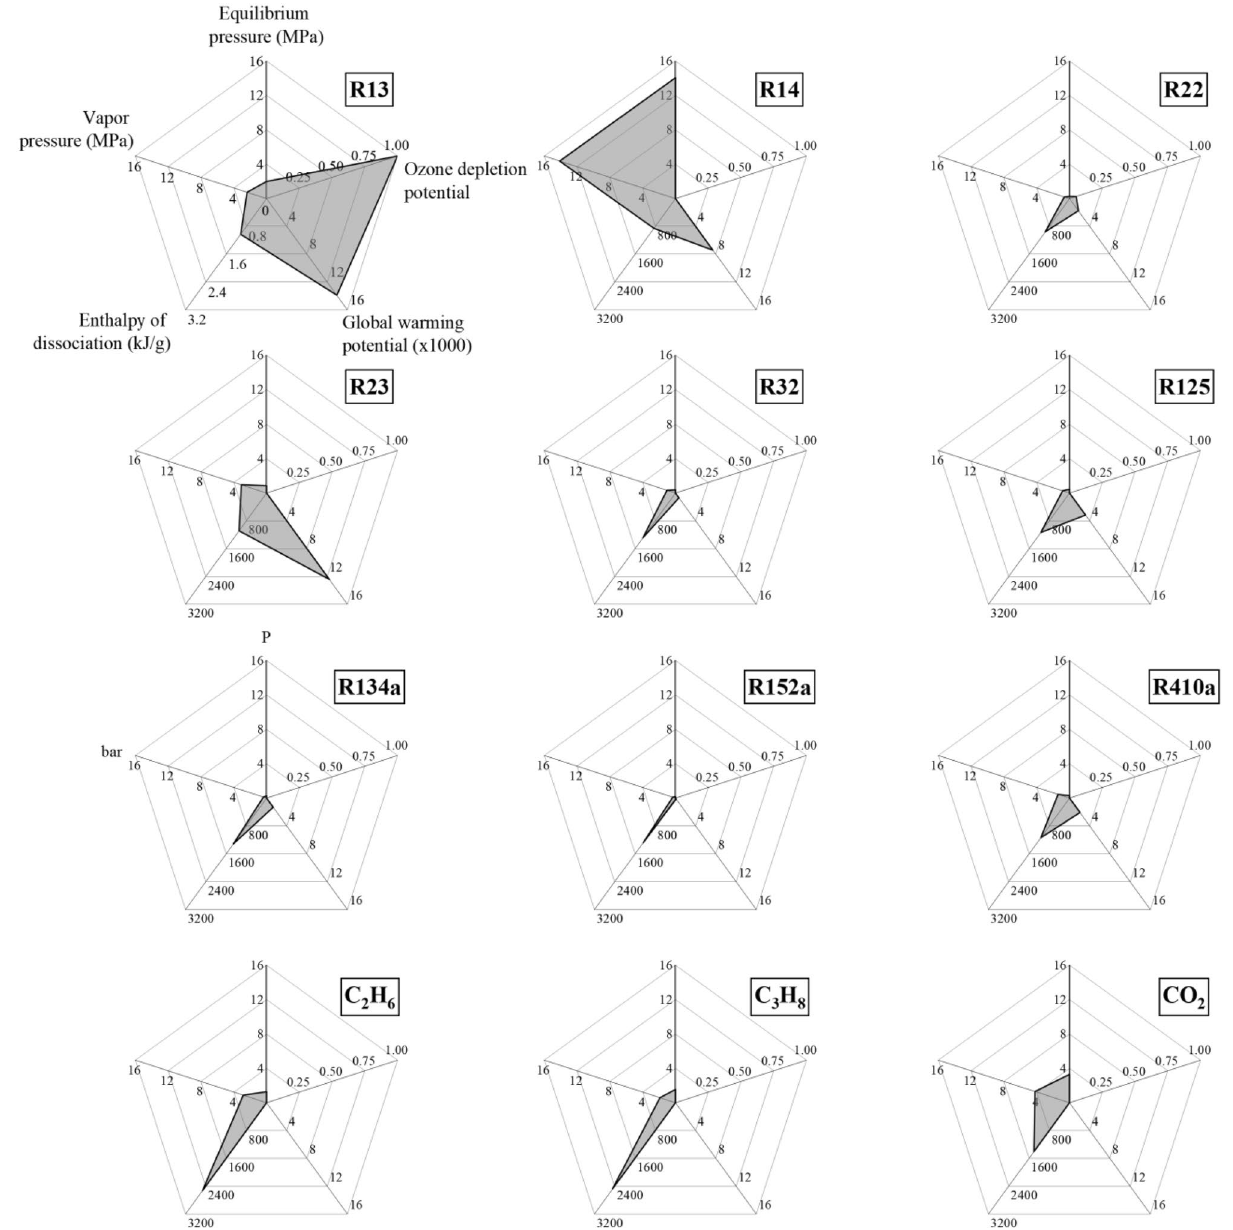
hydrates exhibit most set of desirable properties for these